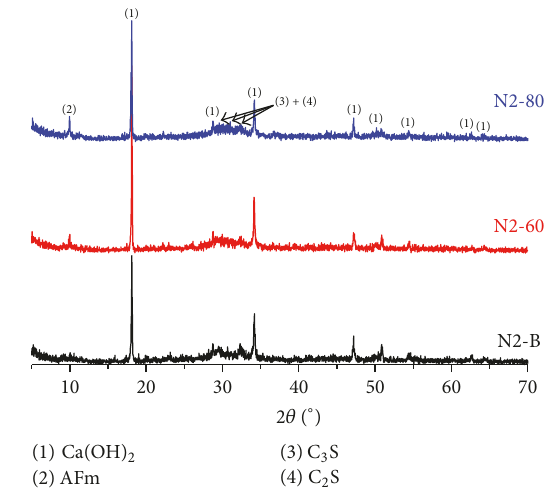
Figure 7: XRD patterns of the paste containing phosphorus slag at the age of 90